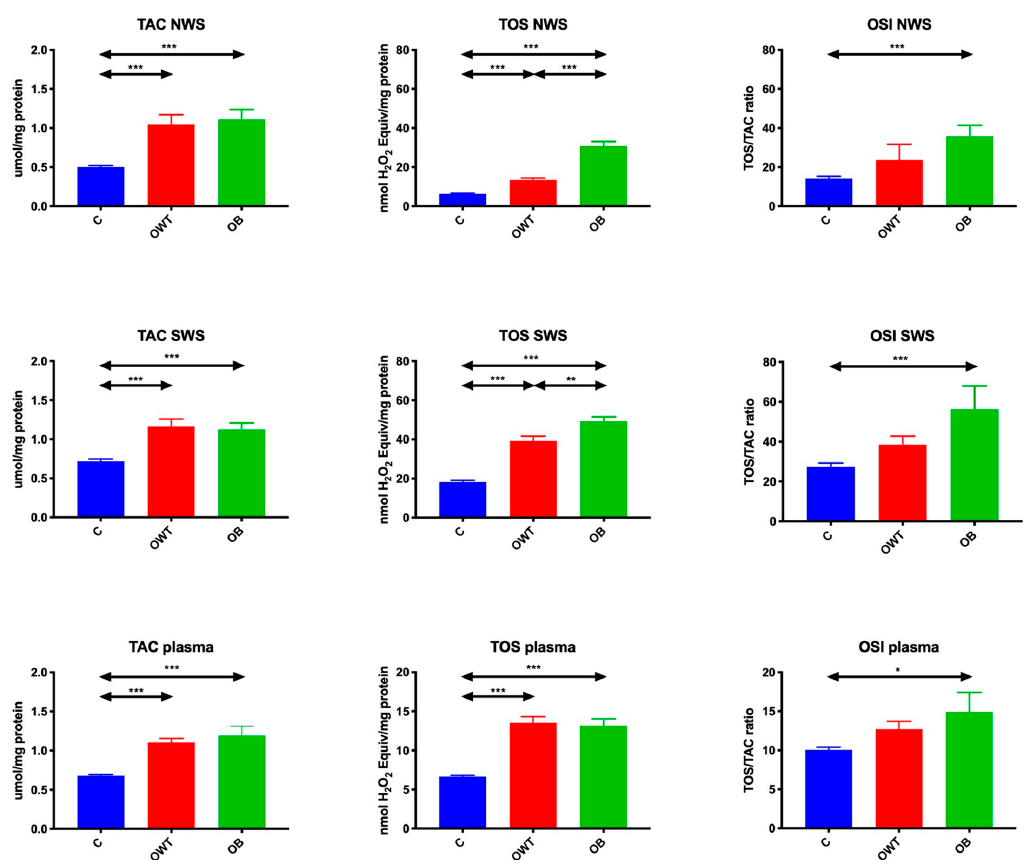
Figure 4. Redox status in overweight and obese adolescents as well as healthy controls. C- control, NWS- non-stimulated whole saliva, OB- obese, OSI- oxidative stress index, OWT- overweight, SWS- stimulated whole saliva, TAC- total antioxidant capacity, TOS- total oxidative status. Differences statistically significant at: * p < 0.05, ** p < 0.005, *** p < 0.0005.